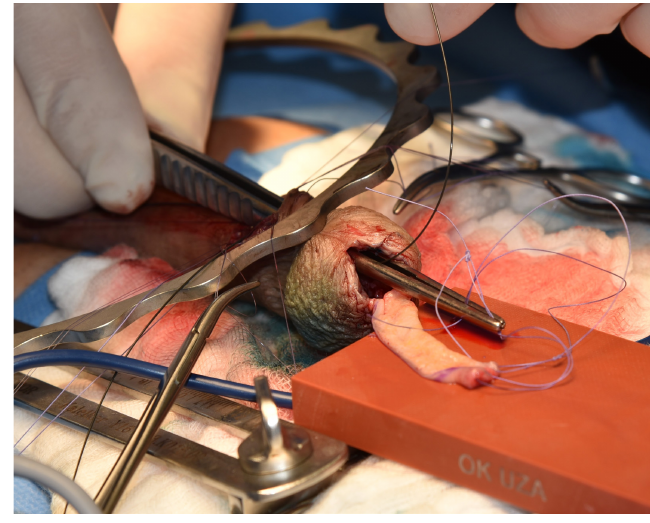
Figure 5. The graft is fully prepared and in this picture already been sutured to the glandular mucosa. It is placed with the mucosal side down and by performing the pull-through maneuver positioned correctly facing up, guided by the “marked” sutures.